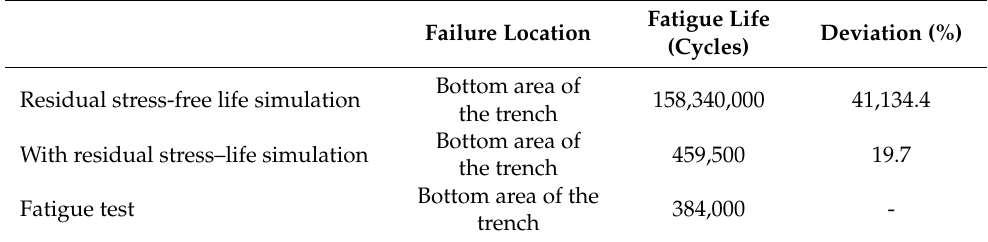
Table 2. Fatigue life calculation results.